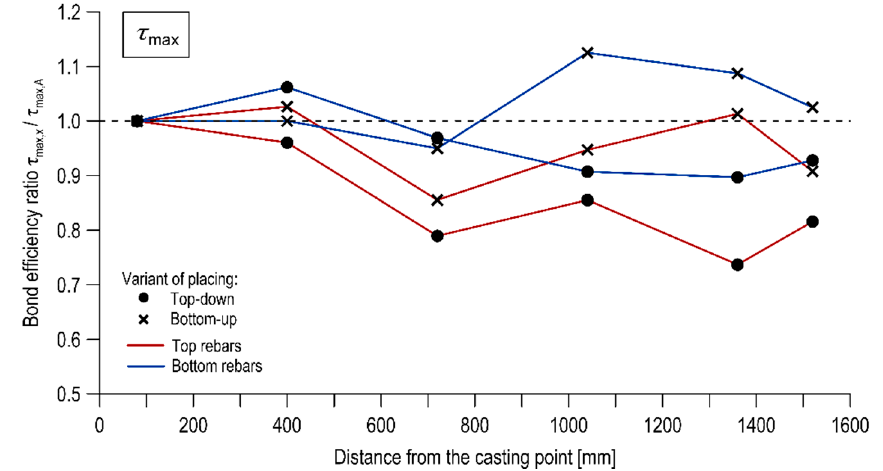
Figure 8. Bond efficiency ratio as a function of rebar position for the ultimate bond stress.